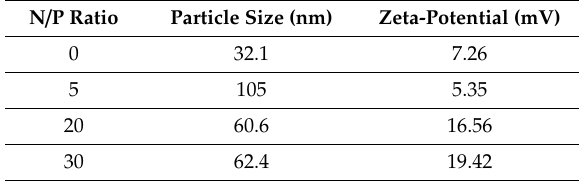
Table 1. Particle size and zeta-potential of MPEG-PCL-Tat / siTNF- α